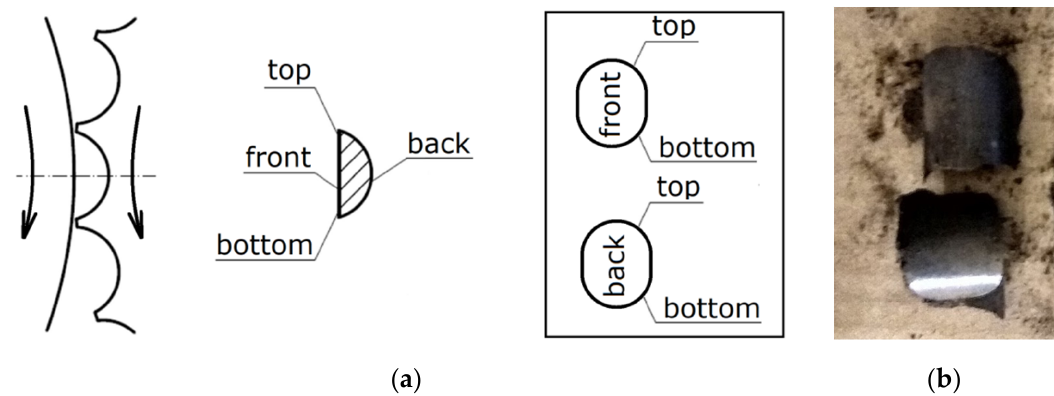
Figure 7. The briquettes arrangement: ( a ) in the compacting unit, ( b ) on the cardboard pad. From 3 to 10 thermal images were taken of the briquettes from each of the mixtures, out of which 3 with the highest maximum temperature were selected for further analysis (Figure 8a). The photos were analyzed using the FLIR Quick Report program v. 1.2 SP1